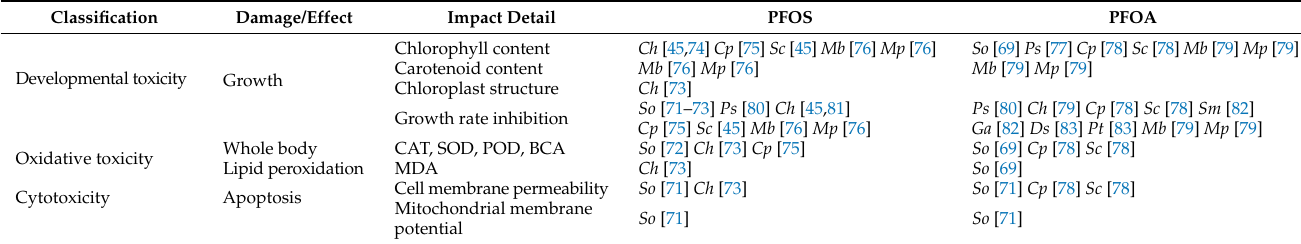
Table 4. Toxicity effects of commonly detected single PFASs on